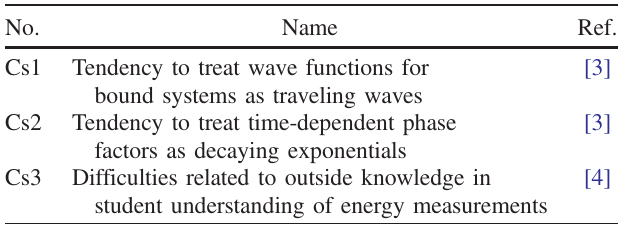
TABLE IV. Difficulties that exhibit only content error in problems which require shifting frames. These difficulties are labeled “ C ” for content errors; and s because their problems require shifting. The ordering of the difficulties in the table is for labeling purposes only and does not represent a hierarchy.